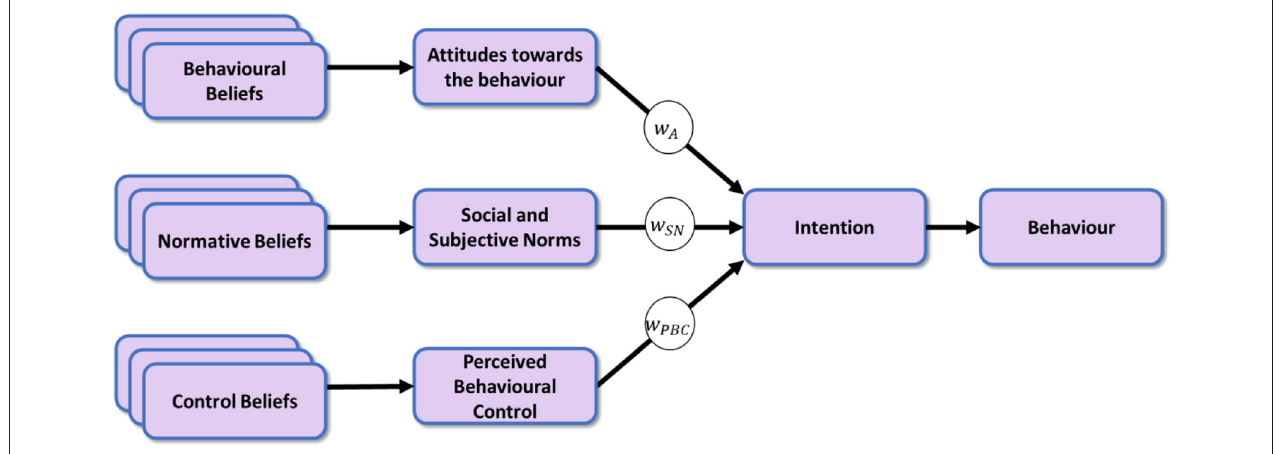
FIGURE 1 | The theory of planned behavior